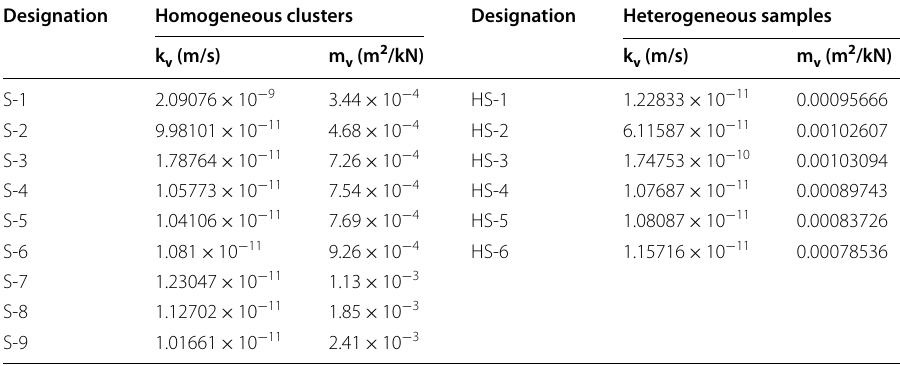
Table 5 Comparison of the compressibility and permeability parameters between the homogeneous soil mixtures and the heterogeneous soil physical